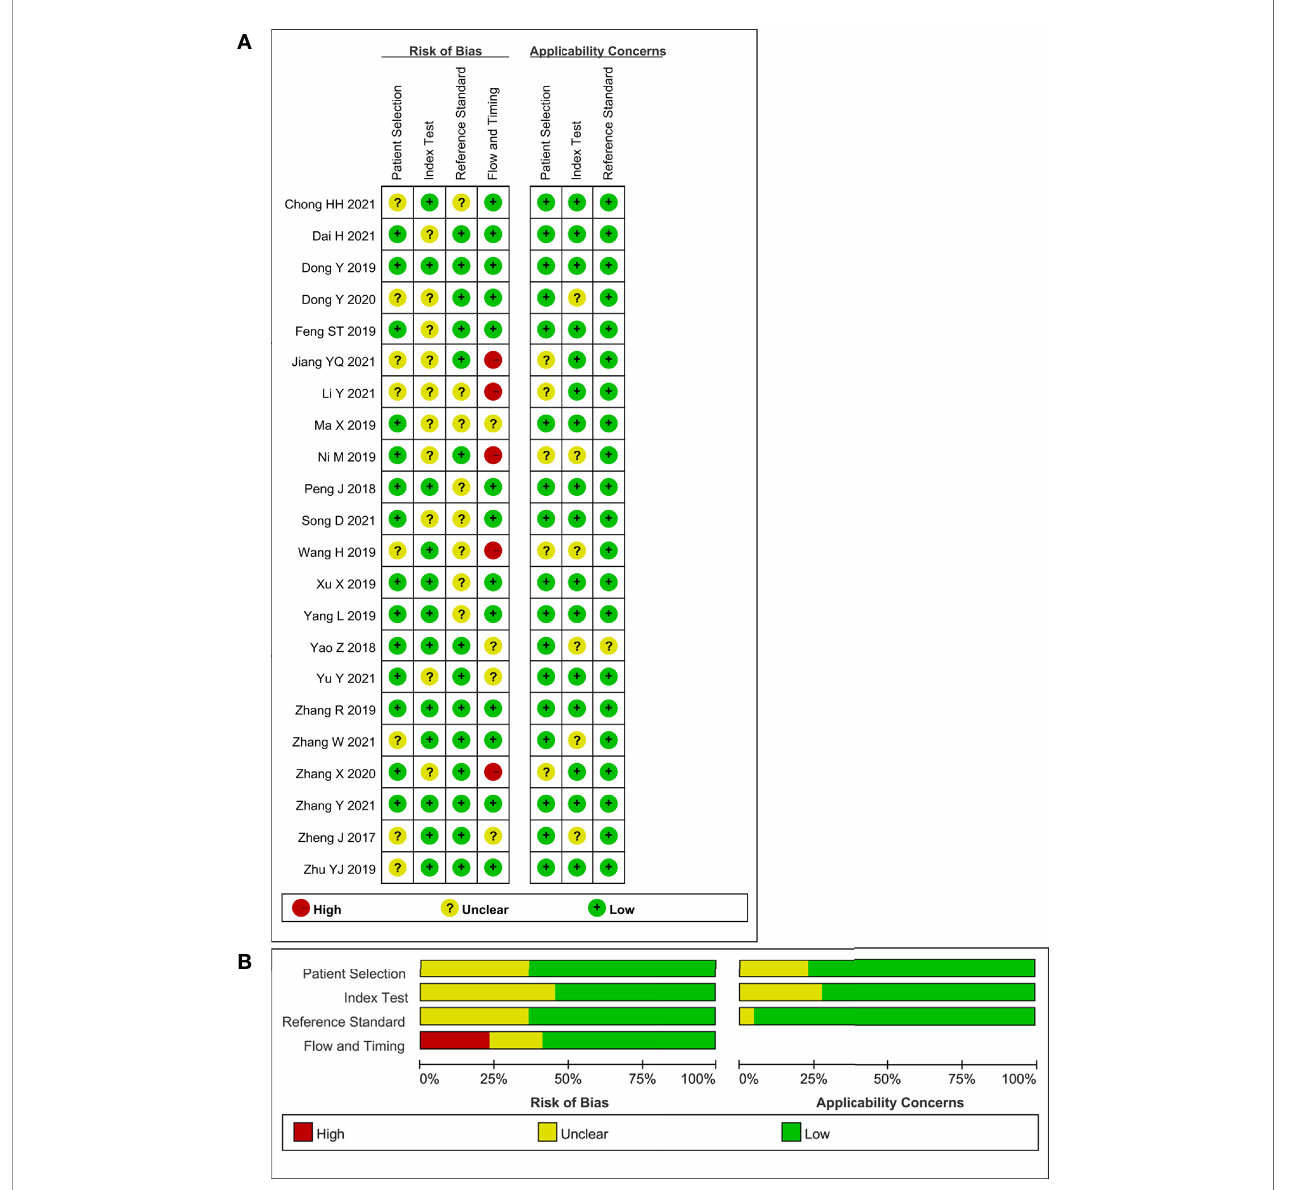
FIGURE 2 | Stacked bar charts of the QUADAS-2 scale of methodological quality assessment. Risk of bias and applicability concerns of each included study. (A) Individual studies, (B) summary. For each quality domain, the proportions of included studies that suggest low, high, or unclear risk of bias and applicability concerns are displayed in green, red and yellow,